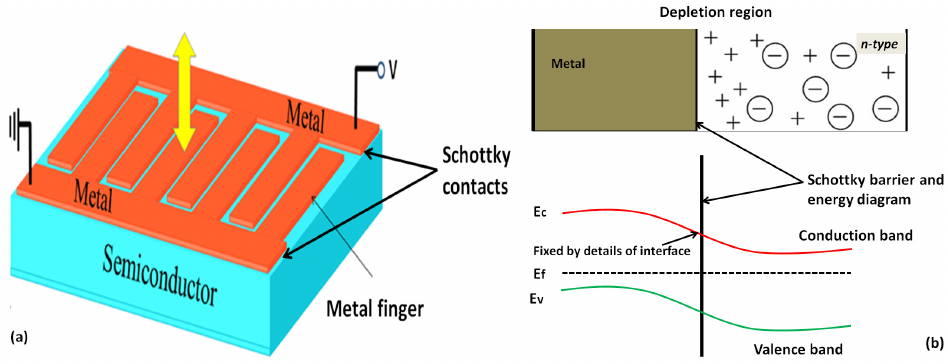
Figure 1. A typical MSM-PD structure contained two Schottky contacts deposited onto a semiconductor substrate and the cross-section of the metal area of the Schottky barrier and energy bandgap [42,61].